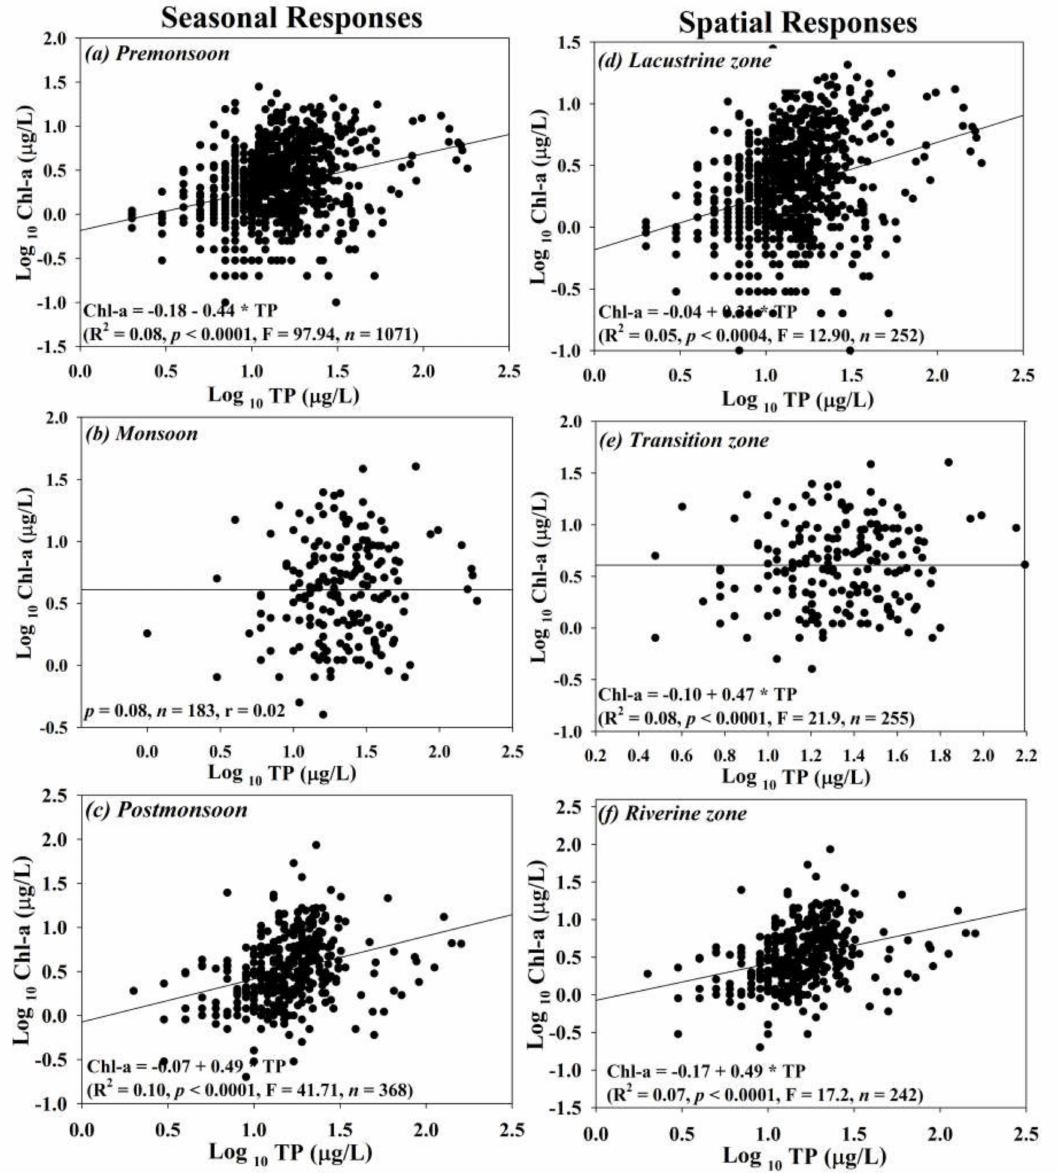
Figure 5. Seasonal ( a – c ) and spatial ( d – f ) response analyses of Chl-a and TP in the Soyang reservoir during 1992–2013; (*)—Multiplication